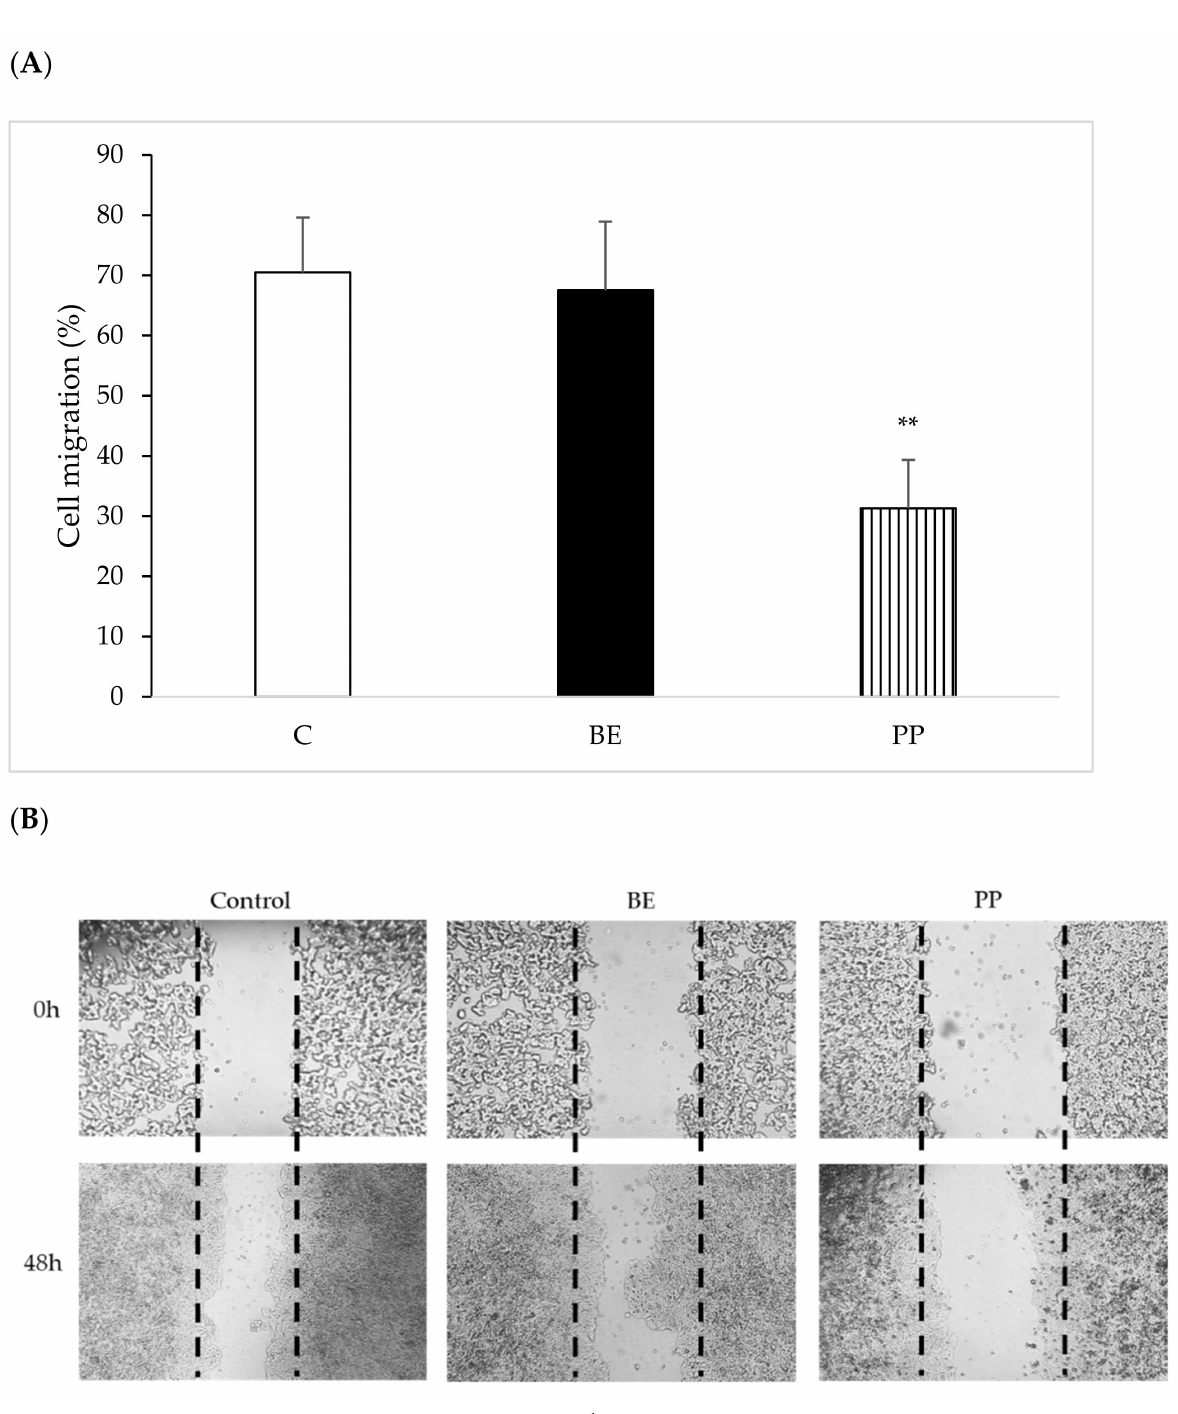
Figure 4. HT29 cell migration after exposure to 100 µ g · mL − 1 of the protein fractions under study: buffer extraction (BE) and deflamin (PP), as determined by the wound healing assay. ( A ) Relative migration rates. Values are the averages of at least three assays ± SD, and are expressed as a % the wound migration in relation to 0 h. ( B ) Representative pictures of cell migration demonstrating the inhibitory effect of deflamin on HT29 cell migration. ** p <